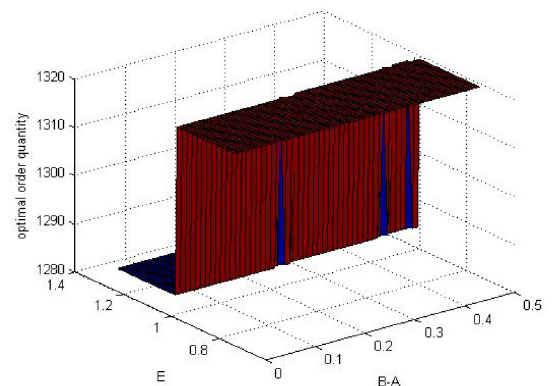
Figure 3. Optimal order quantity with revenue-sharing